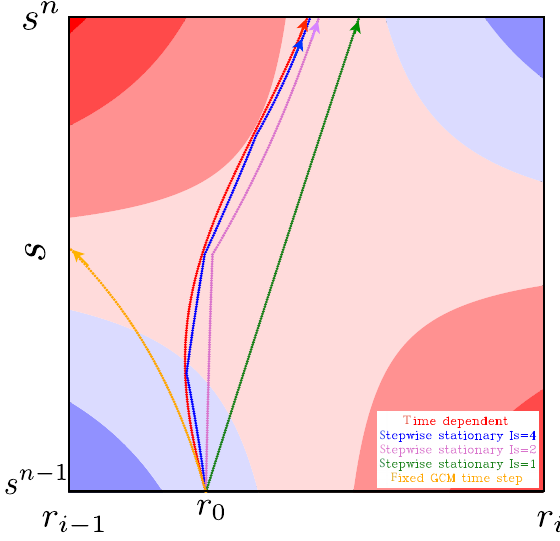
Figure 4. Example of how the trajectories differ when computed with the fixed GCM time step method in orange, the stepwise- stationary method in blue, purple and green as well as the time- dependent method in red. They all start at the same time s n − 1 and in the same position r 0 but exit the grid at different locations and times. Note that the stepwise-stationary method needs at least four intermediate time steps ( I S ) to be close to time-dependent trajec- tory. The background colours are the same as in Fig. 2 with F > 0 in red and F < 0 in